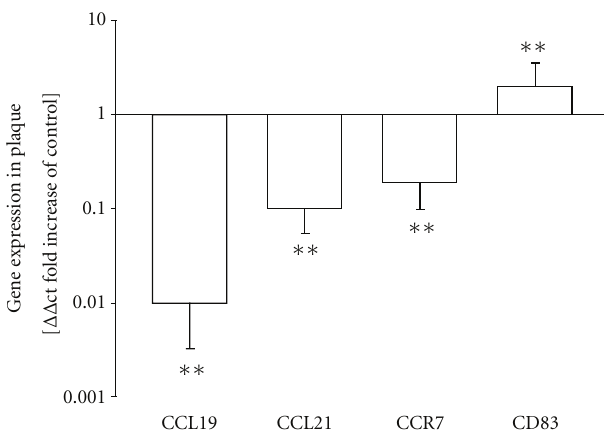
Figure 1: mRNA expression of CCL21/19, CCR7, and CD83 in vascular plaques compared to aortic tissue without plaque detection. In vivo changes (relative fold increases) in mRNA expression of CCL19, CCL21, CCR7, and CD83 in carotid plaques compared to healthy aortic material. ∗ P < 0 . 05, ∗∗ P < 0 . 01, ( n = 47) versus aortic tissue ( n = 14).